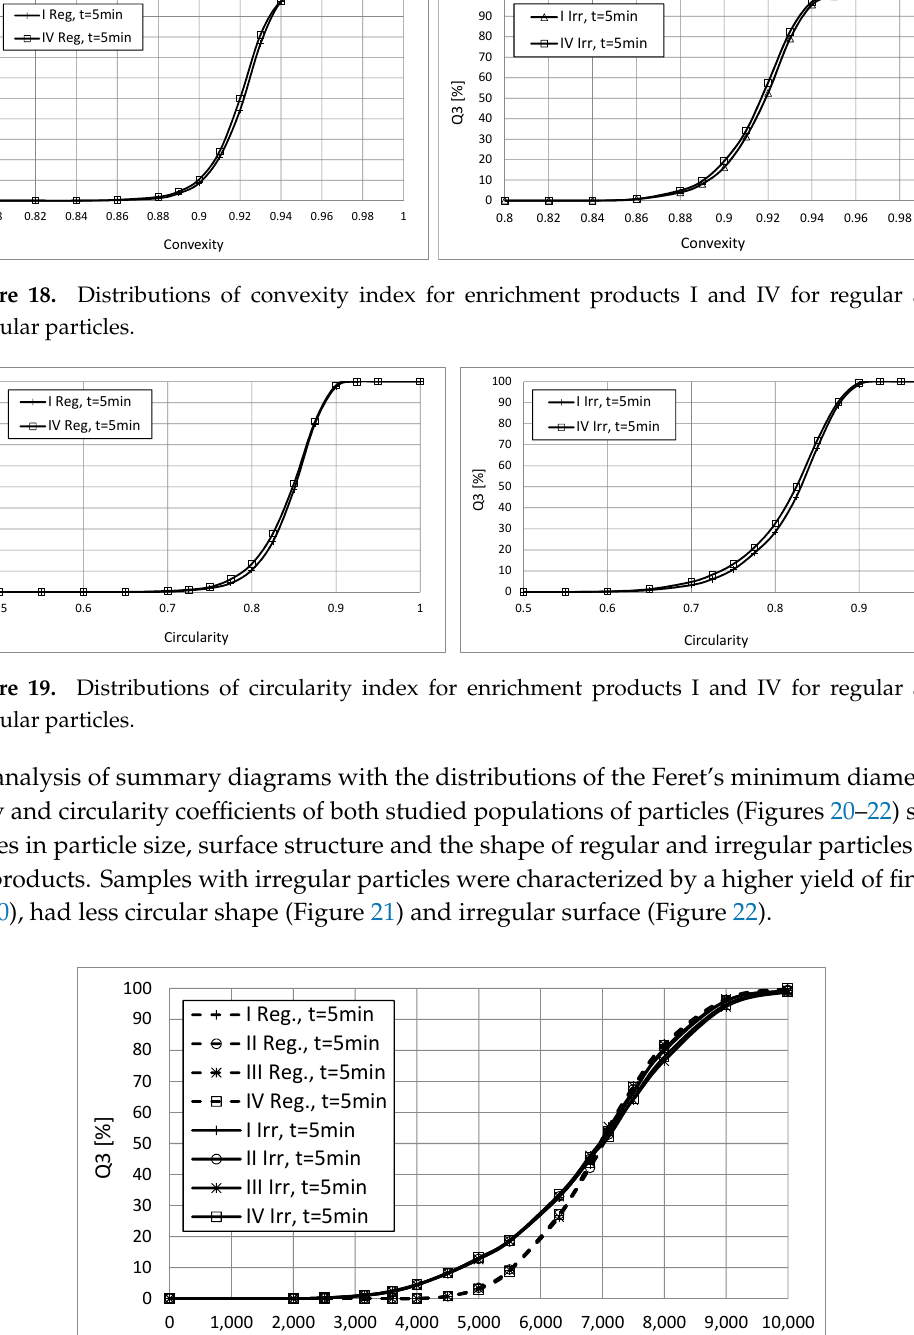
Figure 21. Comparison of Circularity distributions of chalcedonite enrichment products for regular and irregular particles. Figure 22. Comparison of Convexity distributions of chalcedonite enrichment products for regular and irregular particles. 6. Summary and Conclusions The results of investigations show that the shape of particles and the choice of a measure for determining the size of the particle significantly affect the results of particle size measurements by means of visual methods. The dynamic image analysis (DIA) technique gives repeatable and reliable